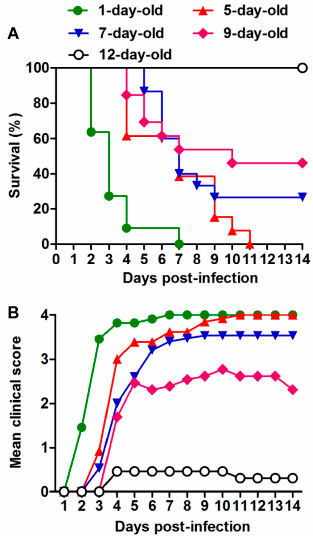
Figure 2. Age dependence of EVD68-induced disease and mortality. ICR mice ( n = 11–15/group) were injected i.p. with 2.0 × 10 6 TCID 50 of US/MO/14-18947 per mouse at 1, 5, 7, 9 or 12 days of age. ( A ) Survival and ( B ) clinical score were then monitored and recorded daily after infection. Clinical scores were graded as described in the legend of Figure 1.